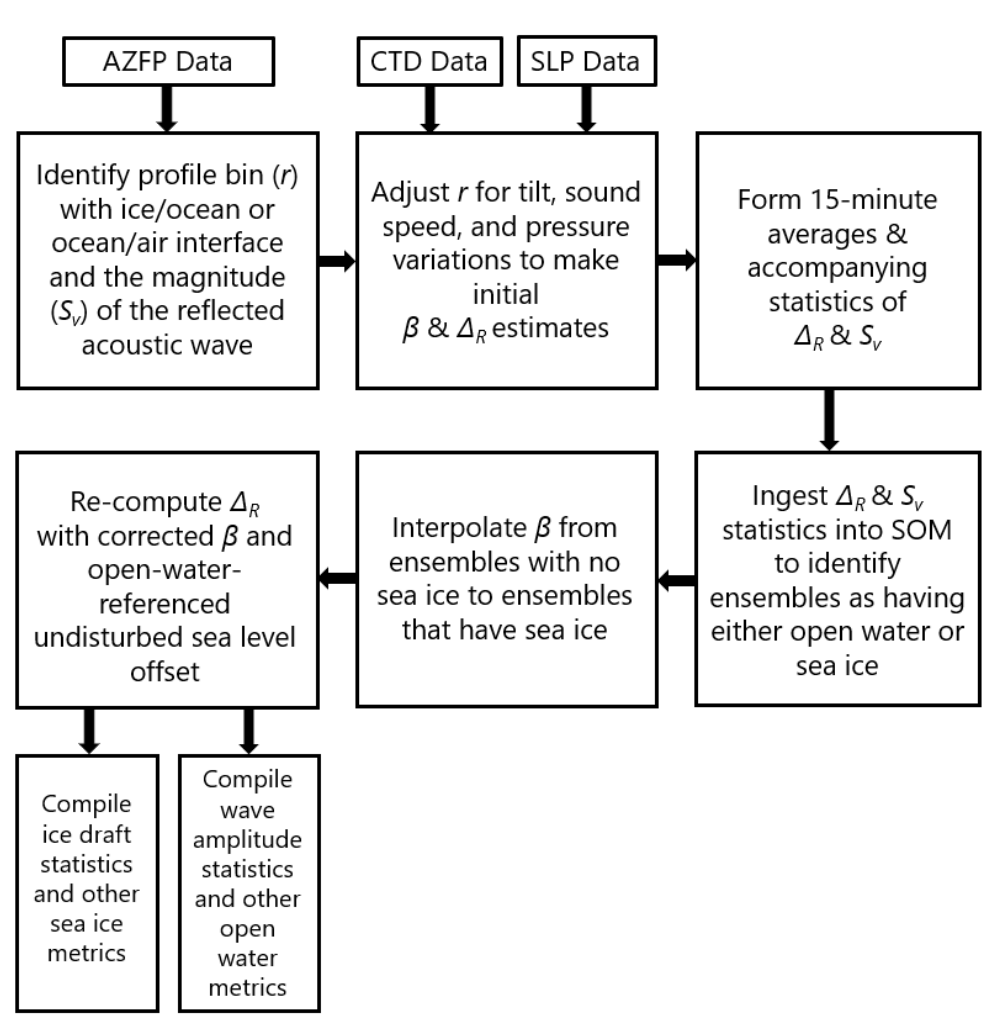
Figure 5. Signal processing flow chart detailing steps for automating estimates of sea ice draft, wave amplitude, and associated statistics from the upward-looking sonar Acoustic Zooplankton Fish Profiler (AZFP) acoustic backscatter data and accompanying conductivity-temperature-depth (CTD) and atmospheric sea level pressure (SLP) datasets. S v represents the amplitude of the acoustic backscatter relative to the transmitted signal, r is the raw (unadjusted) distance from the acoustic transducer to the ice/ocean or ocean/atmosphere interface, β represents a correction for changes in the speed of sound due to water density fluctuations, and ∆ R is the calculated difference between the mean sea level and the sea surface/bottom of the ice. A self-organizing map (SOM) machine learning algorithm identifies intervals of open water and sea ice cover.